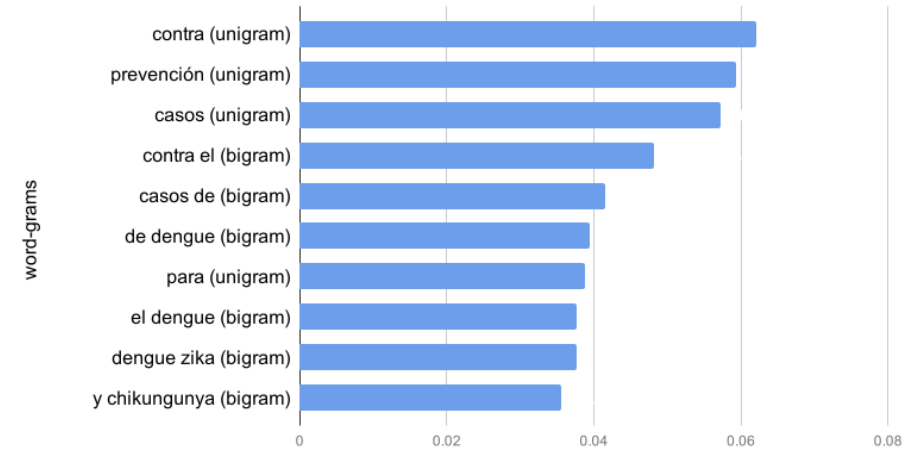
Figure 14. Information gain for the best ten unigrams, bigrams and trigrams of the word-gram model.